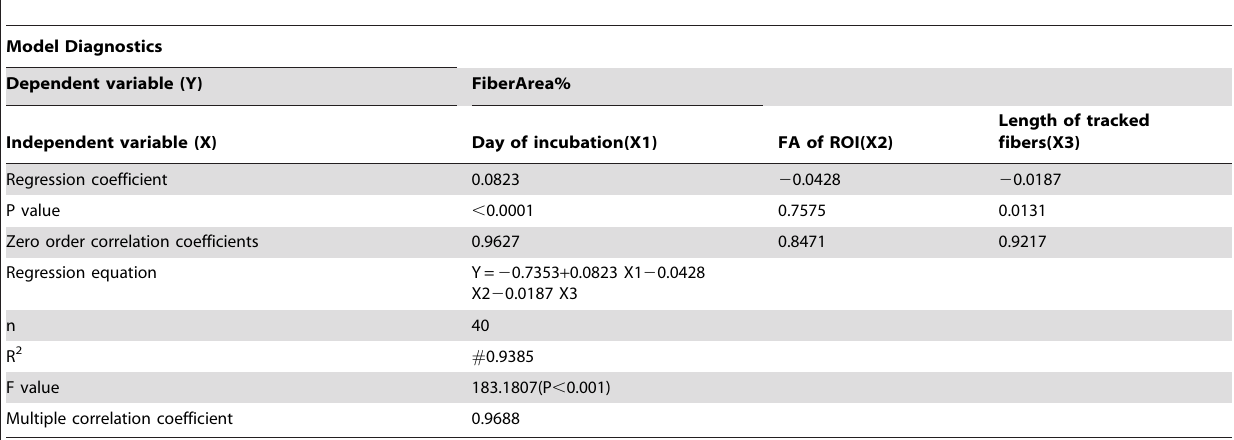
Table 2. Multiple linear regression among FiberArea%, Day, FA and